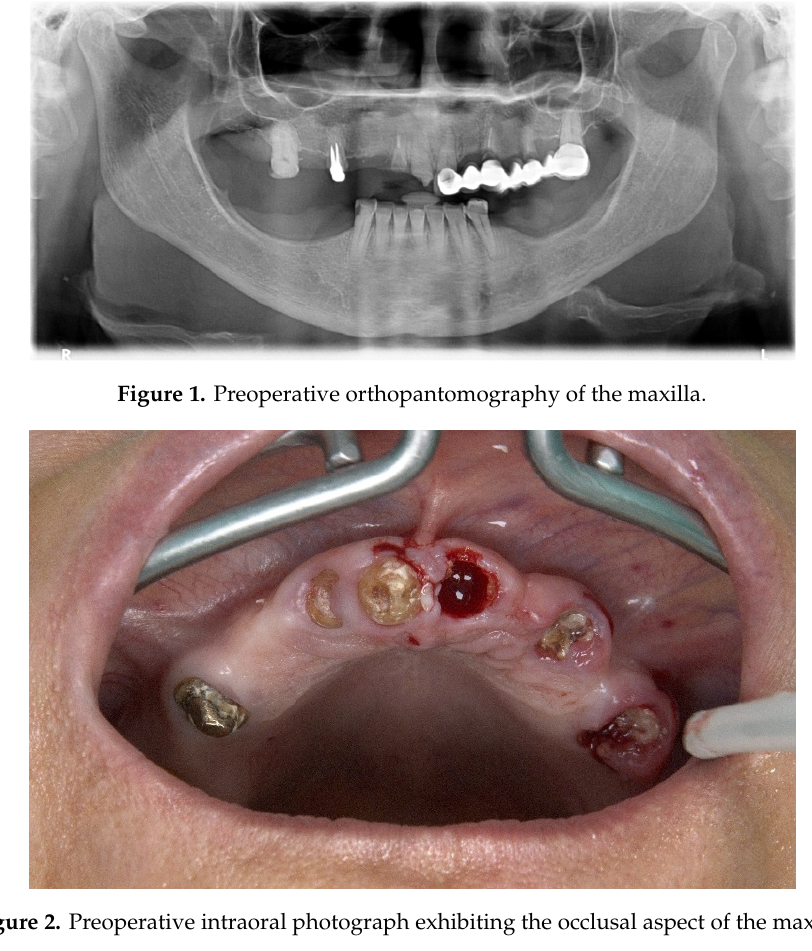
Figure 2. Preoperative intraoral photograph exhibiting the occlusal aspect of the maxilla.